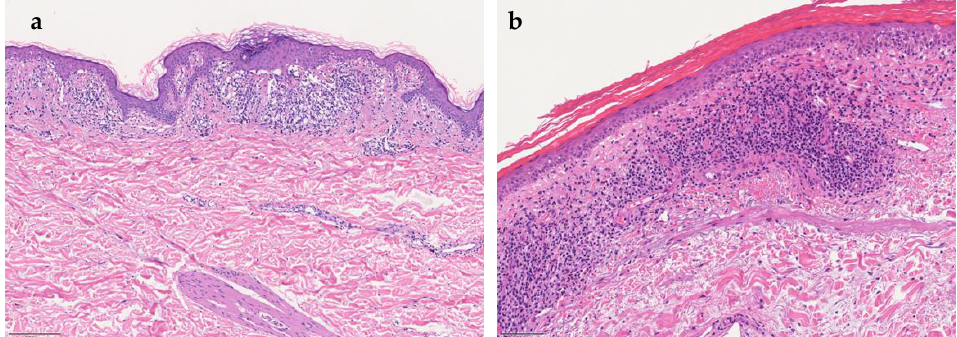
Figure 1. ( a ) Histopathological specimen shows dilated blood vessels, mild perivascular and li- chenoid lymphocytic infiltrate, exocytosis of erythrocyte, and focal epidermal spongiosis. (Hema- toxylin- eosin stain). ( b ) Lichen aureus: dense lichenoid infiltrate associated with dilatated blood vessels and normal epidermis. blood vessels and normal